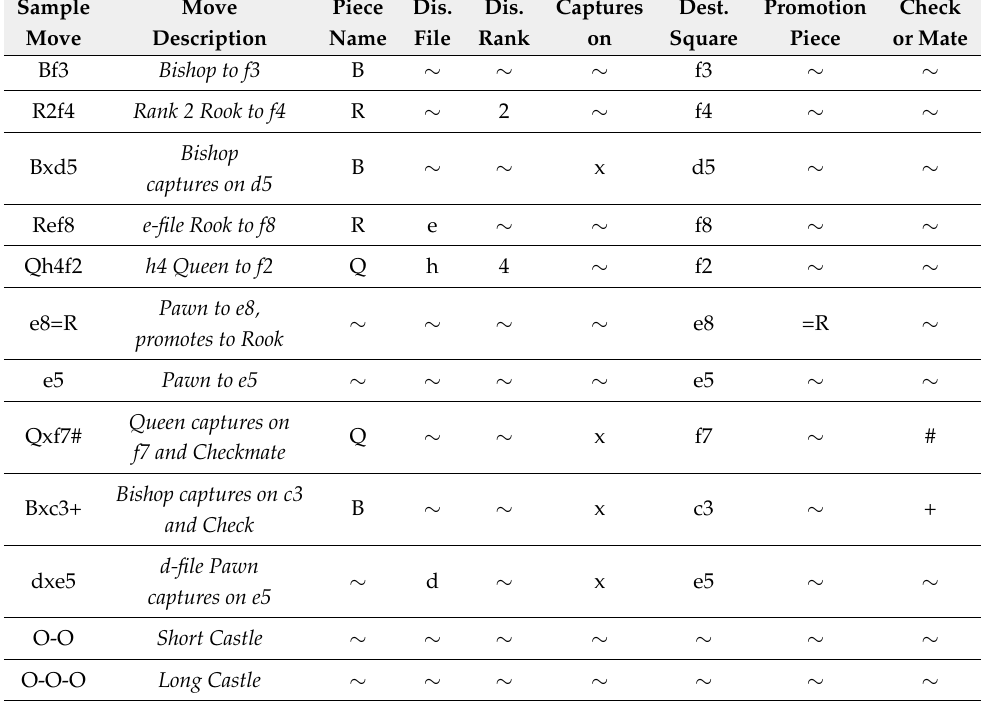
Table 2. Example chess moves with their descriptions and how they are interpreted in SAN for- mat. Dis. or disambiguation file or rank is used only when multiple pieces can move to the same destination